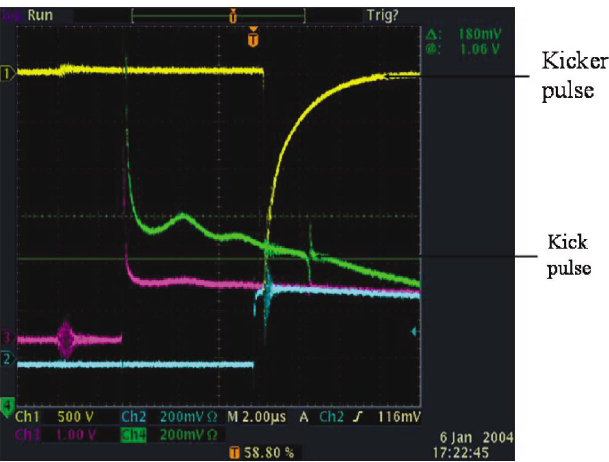
FIG. 21. (Color) Typical waveforms of kicker (yellow trace) and kick (green trace) pulses for time-of-flight measurements. The oscilloscope vertical scale is arbitrary, the horizontal scale is 2 (cid:29) s per division. The magenta and blue traces are auxiliary traces captured in this image.